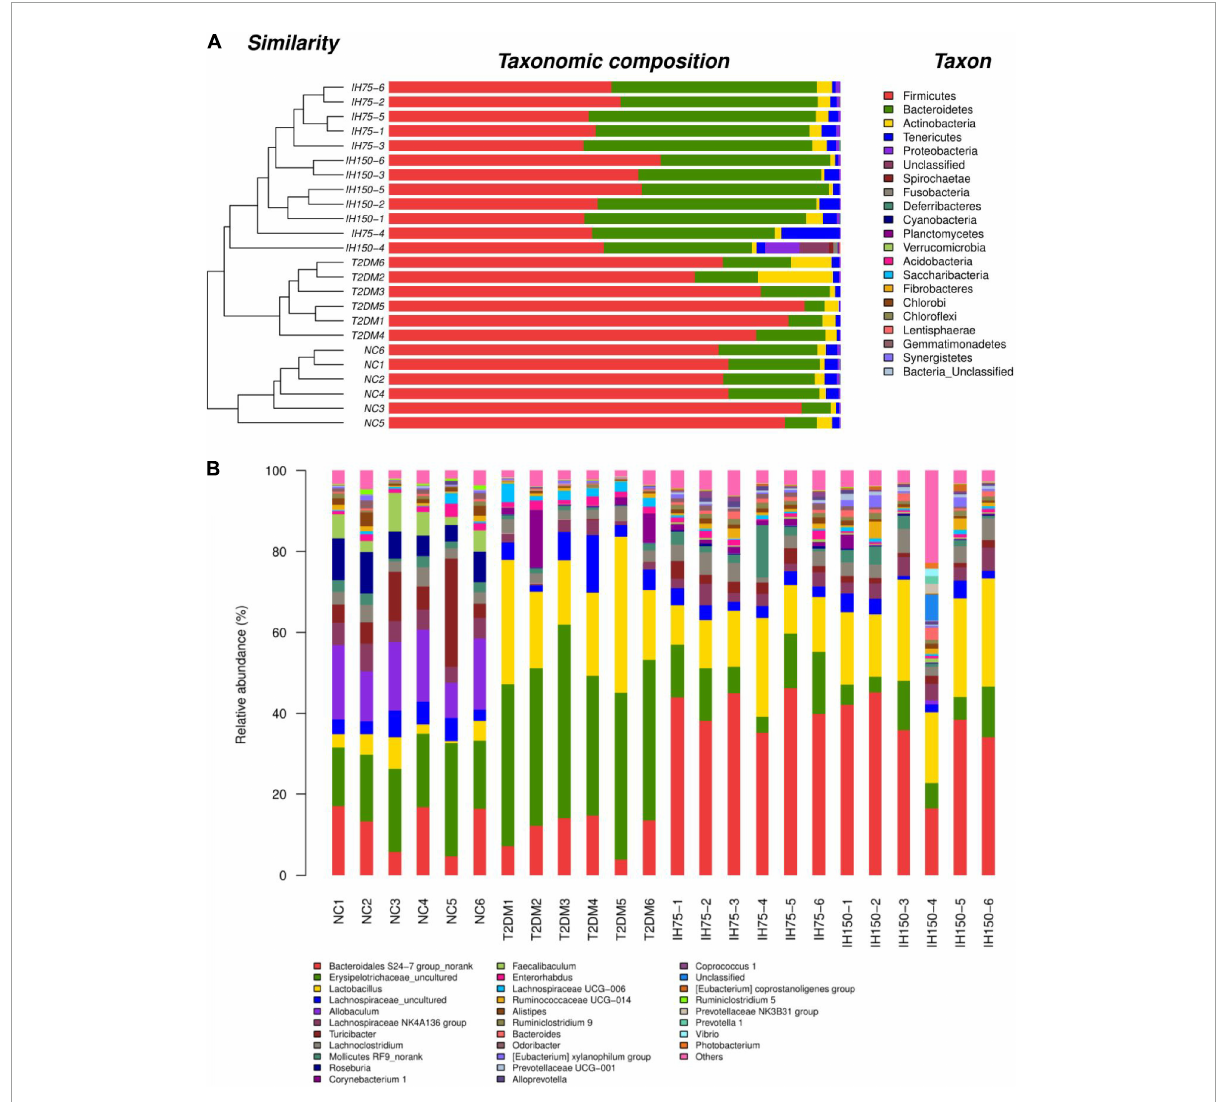
FIGURE5 Effect of IH on bacterial microbiota composition (A) dendrogram with bar graph of phyla; (B) relative abundance of